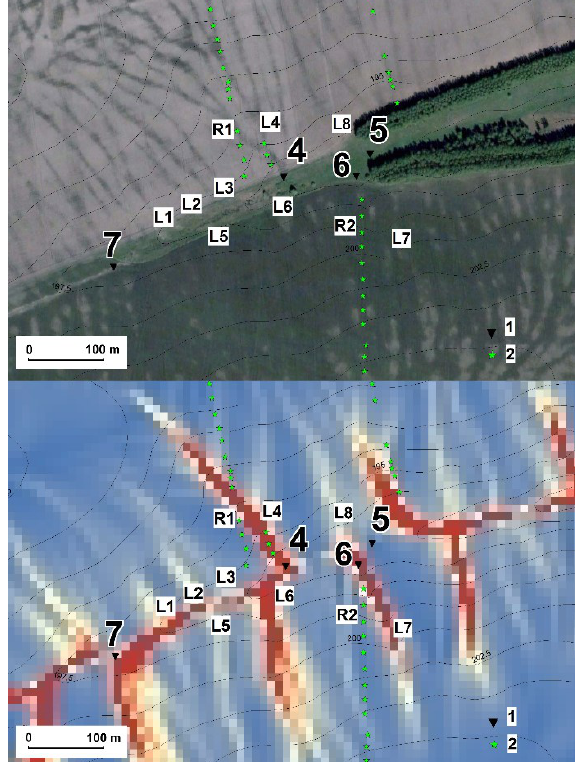
Figure 3 . Fragments of satellite image (courtesy of the DigitalGlobe Foundation) of the ground test plot (upper image) and catchment area map (lower image) of the ground test plot; items 1 and 2 in the legends – soil sampling point locations (respectively discussed and not discussed in the paper text); L1- L8 micro-ravine labels; R1, R2 modern stream labels.